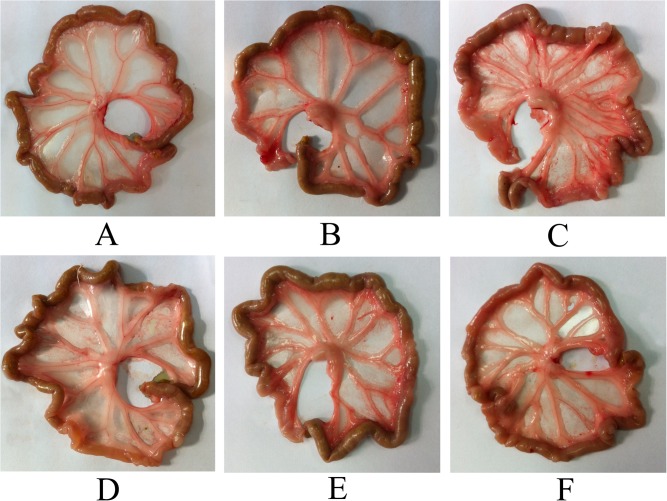
Gross appearance of mesentery under direct view.A: Group CON, transparent mesentery with few small vessels; B: group NS, transparent, with slight hyperplasia of mesenteric vessels; C: group GLU, translucency, with obvious hyperplasia of mesenteric vessels and white fibrous material deposition at the origin of mesenteric artery; D: group HEP, translucency, with obvious hyperplasia of mesenteric vessels; E: group LLMWH, transparent, with slight hyperplasia of mesenteric vessels; F: group HLMWH, transparent, with slight hyperplasia of mesenteric vessels.